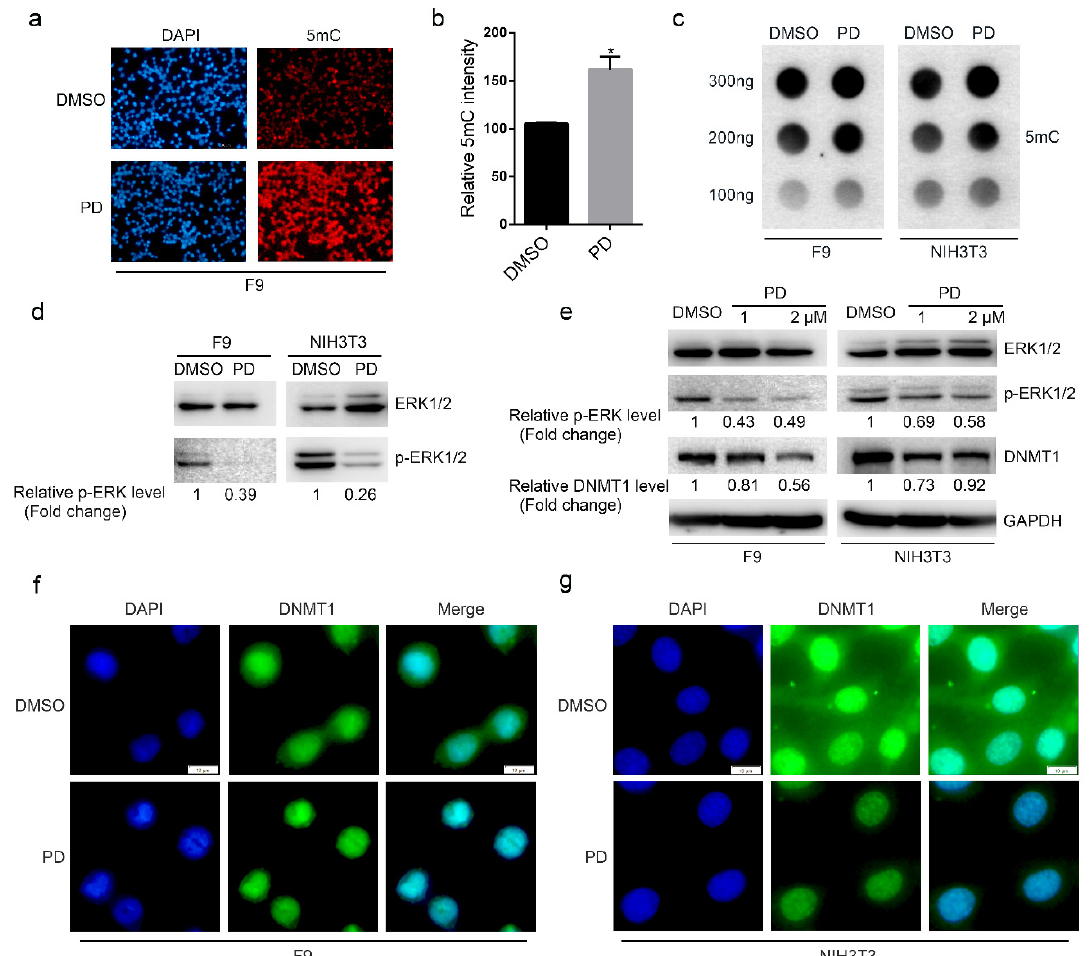
Figure 2. ERK regulates genome-wide DNA methylation. ( a , b ) PD treatment increased genome-wide 5 mC levels in F9 cells. F9 cells were treated with 1 µ M PD for 12 h, after which a methylation staining experiment was performed. ImageJ 1.49 software was used to determine 5 mC fluorescence intensity, and three images were analyzed for both the DMSO and PD groups. * p < 0.05. ( c ) PD treatment increased genome-wide 5 mC levels in F9 and NIH3T3 cells. F9 and NIH3T3 cells were treated with 1 µ M PD for 12 h, after which genomic DNA was extracted and a dot blot experiment was performed. ( d ) Western blot results showing the effect of PD treatment. ( e ) PD treatment downregulated the expression of DNMT1. F9 and NIH3T3 cells were treated with 1 or 2 µ M PD for 12 h, respectively, after which total protein samples were obtained for Western blotting. ( f , g ) PD treatment promoted the nuclear localization of endogenous DNMT1 in F9 and NIH3T3 cells. F9 and NIH3T3 cells were treated with 1 µ M PD for 12 h, and immunofluorescence staining was